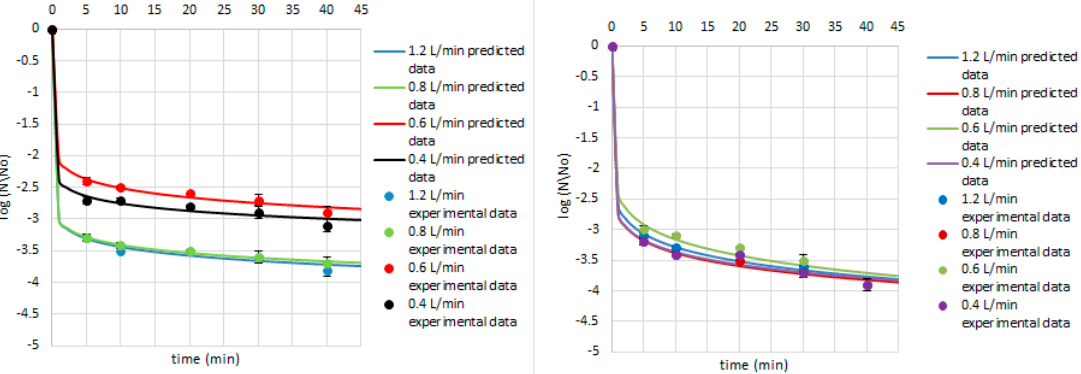
Figure 9. Survival of E. cinnamopurpureum on the cardamom seed ( left ) and juniper berry ( right ) matrix treated with ozone doses stimulated with flow rate of 1.2, 0.8, 0.6, and 0.4 L/min after 5, 10, 20, 30, and 40 min. Solid line: fit of the Weibull model (egn 1), dotted line: bacterial log counts.